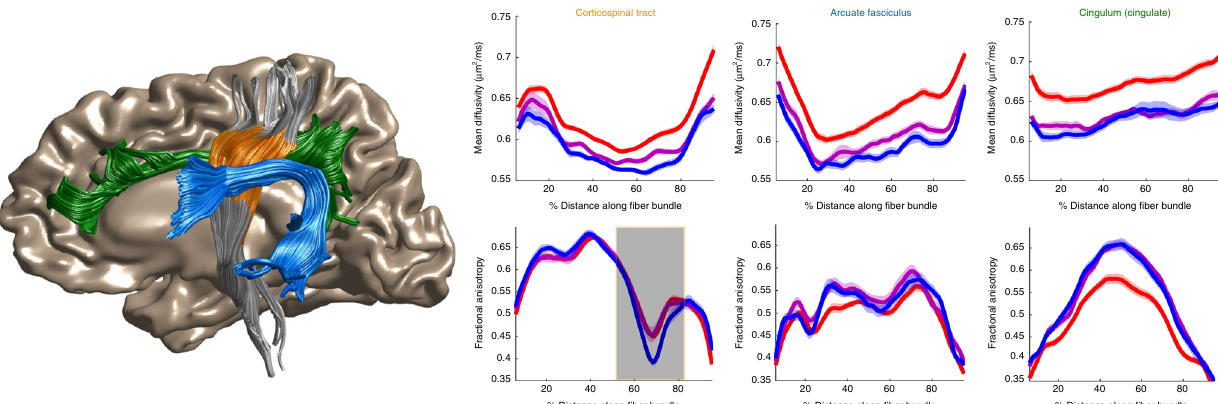
Fig. 1 Development of the corticospinal tract, arcuate fasciculus, and cingulum. Tract pro fi les of mean diffusivity (top) and fractional anisotropy (bottom) are shown for the left hemisphere corticospinal tract (CST, orange), arcuate fasciculus (blue), and cingulum (green). Splitting the group by age, and selecting 3 bins, displays mean lines of three groups: 8 – 15 (red), 15 – 30 (purple), and 30 – 50 (blue). For the CST, there is a region that shows a decrease in FA with development, and this location of the tract is highlighted on the plot using the “ brushable tracts ” feature (shaded gray box). The linked view in the anatomy displays the portion of the CST that is brushed in the plot demonstrating that this effect occurs in the anatomical portion of the CST known as the centrum semiovale, adjacent to the arcuate fasciculus. This linked visualization provides a connection between the data plots and the 3D Anatomy. Data and MATLAB code are available at https://github.com/YeatmanLab/AFQ-Browser_data (see Figure2_Development.m) and running AFQ-Browser instance at: